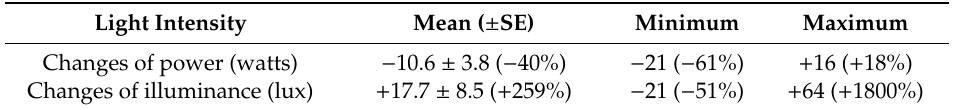
Table 1. Variations in power and illuminance at Rowse et al.’s study [17]. Variations were computed as the di ff erences between the power / illuminance of low pressure sodium (LPS) in experimental before the switch-over and the power / illuminance of LED after the